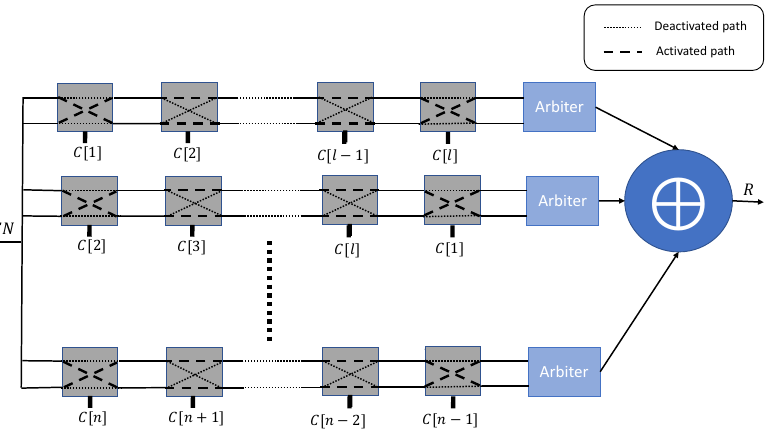
Figure 3. n -XOR Arbiter PUF variant with a derivative challenge for each